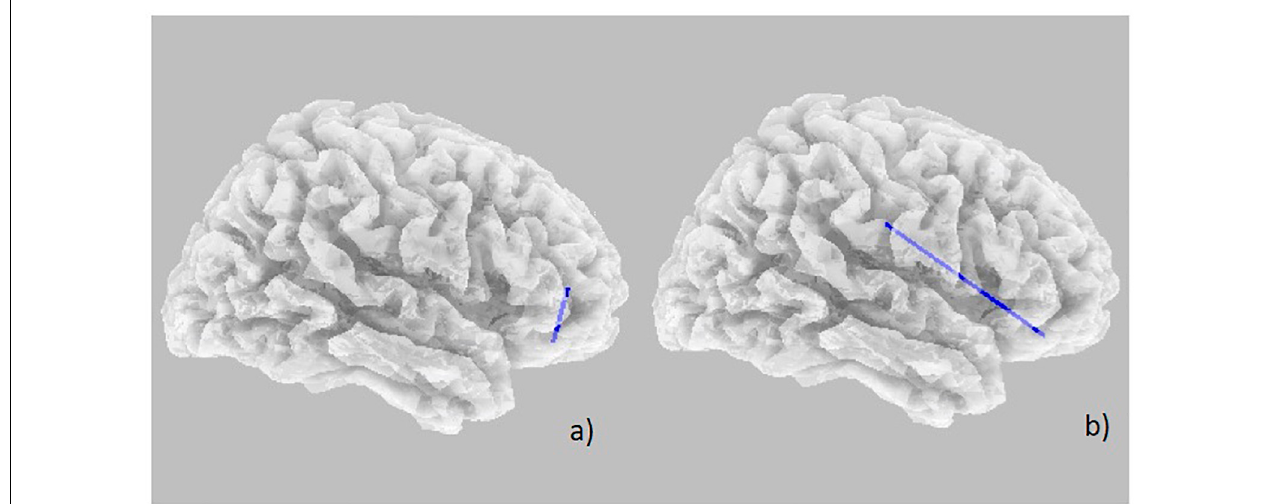
FIGURE 3 | Decrease in “lagged phase synchronization” (blue lines). (a) Correlations with SDMT (correct answer item) in pHD in the Beta 1 band between right BA 46 and right BA 47; (b) Correlation with SWRT (error item) in mHD patients in the Alpha 2 band between right BA 47 and right BA 3.